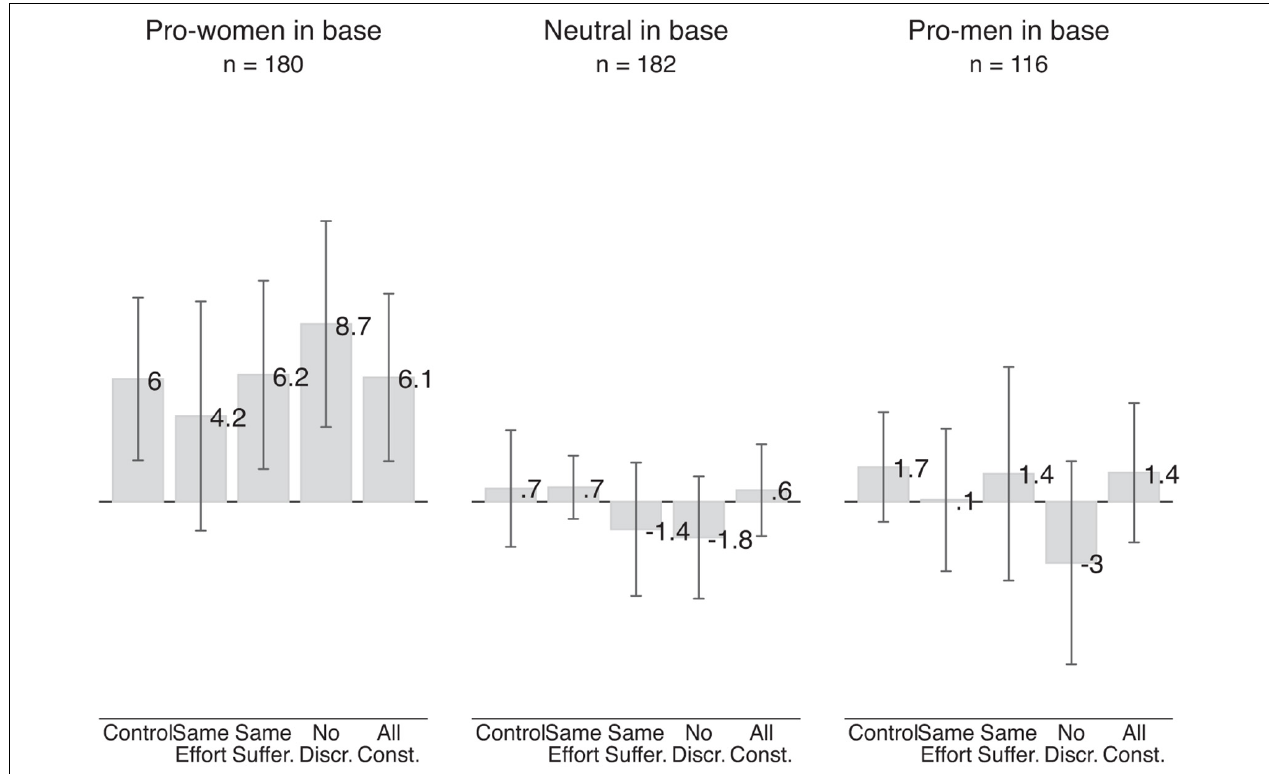
FIGURE 6 | Effect of information treatments on pro-women attitude (Qualtrics sample). The gray bars show the average pro-women attitude in a given treatment. The left-most bar is based on 688 judgments made by 86 respondents who were pro-women in the base scenarios and were randomly assigned to the control group, judging four pairs of scenarios involving two judgments each. Each of the next four bars is based on 188 judgments made by 94 respondents who were pro-women in the base scenarios and were randomly assigned to any of the three treatment groups. Similarly, the left-most bar in the middle section is based on 744 judgments by 93 respondents who were neutral in the base scenario, and each of the next four bars is based on 178 judgments made by 89 respondents. The left-most bar in the right-most section is based on 480 judgments made by 60 respondents who were pro-men in the base scenario, and each of the next four bars is based on 112 judgments by 56 respondents. Vertical lines show 95 percent confidence intervals based on standard errors clustered at the individual